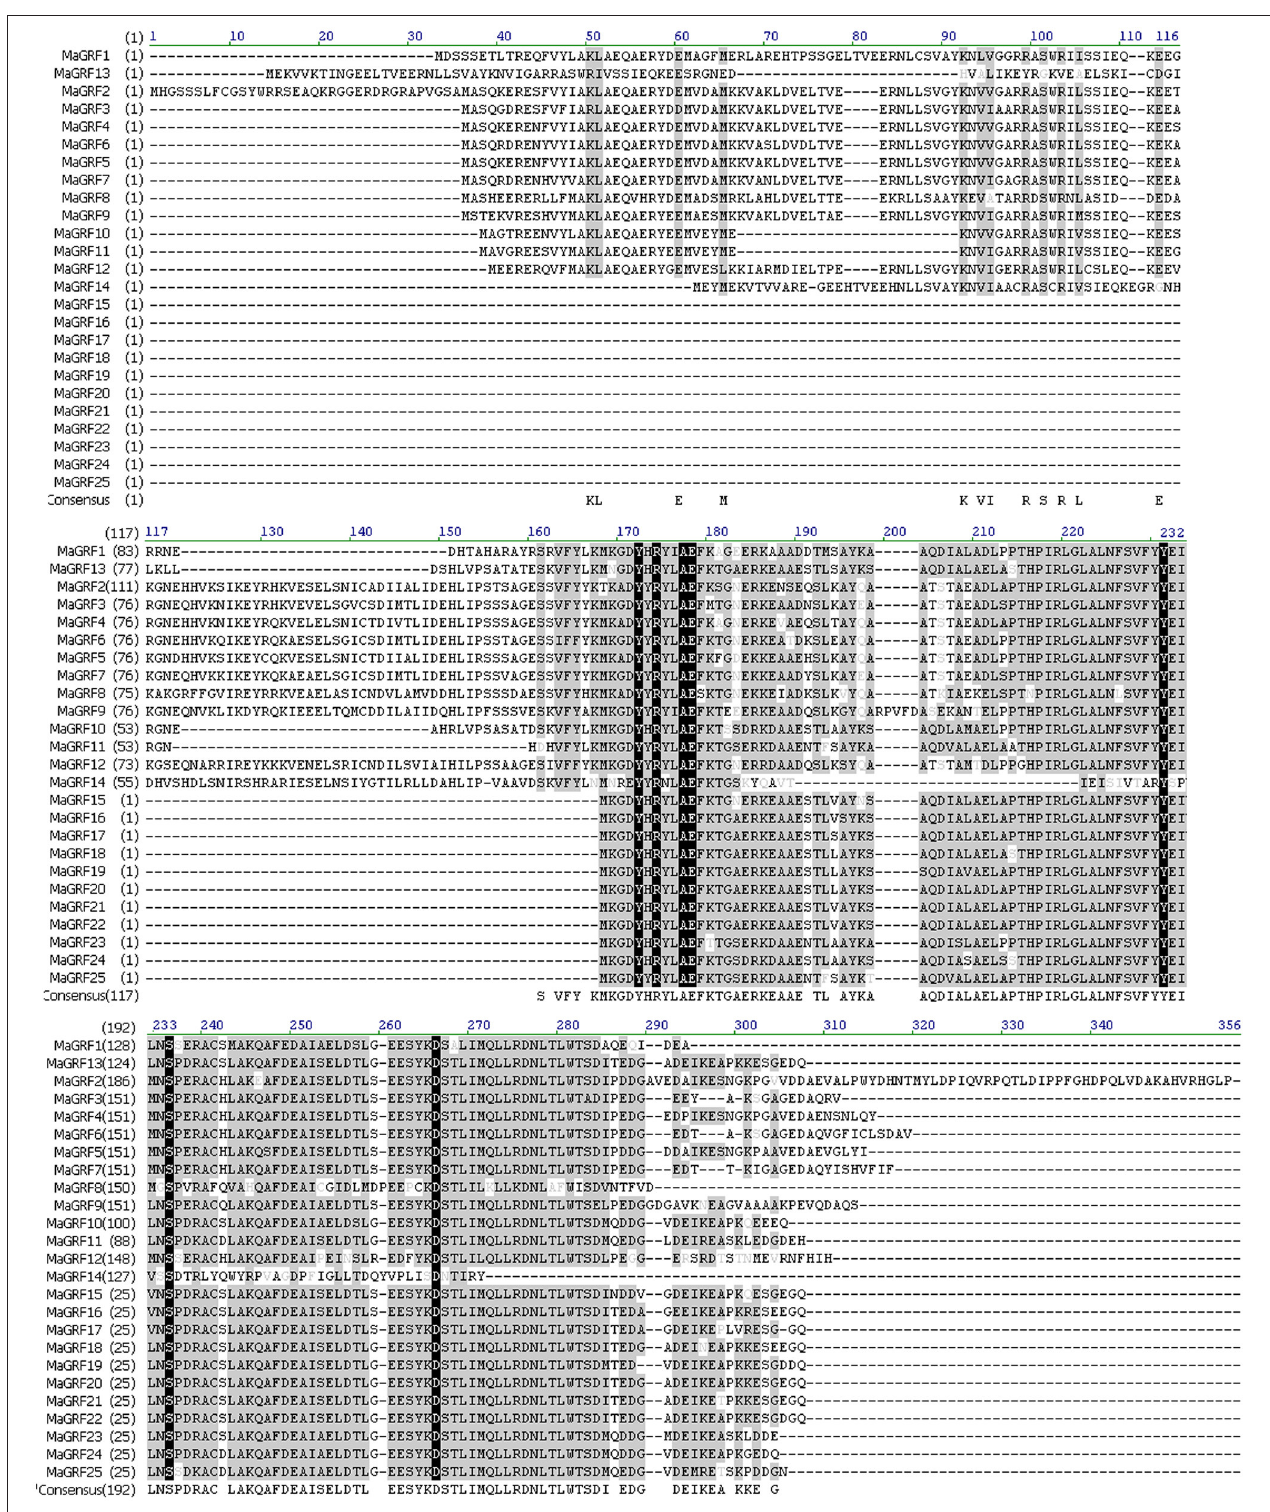
FIGURE 1 | Amino acid alignment of the deduced banana 14-3-3 proteins. Multiple alignments of the amino acid sequences of 25 banana 14-3-3 genes were analyzed by Vector NIT Suite 11.0, amino acids with high identities were shown in black or gray background.